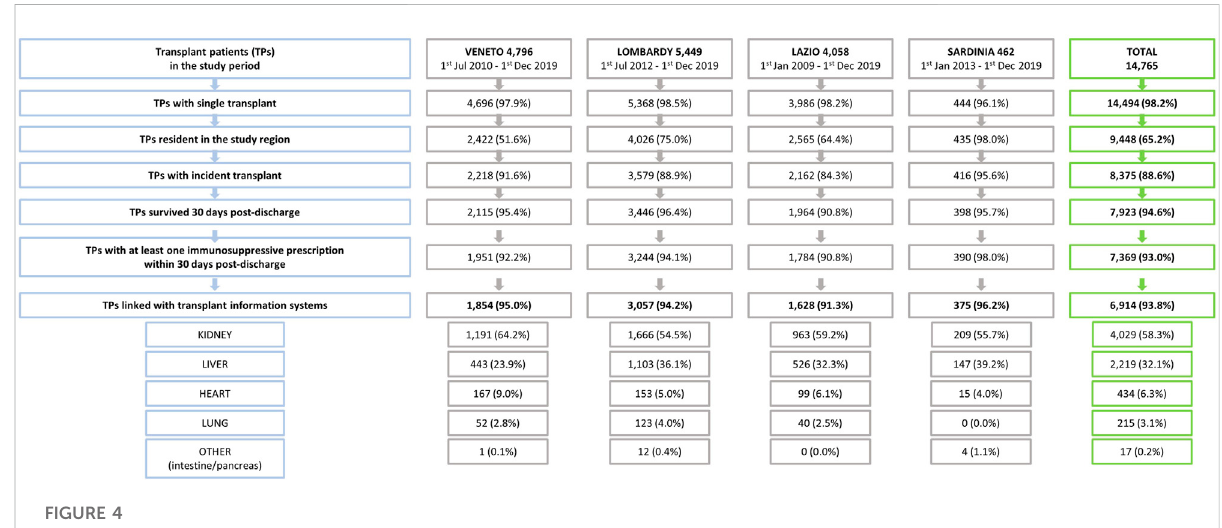
FIGURE 4 Study design including inclusion/exclusion criteria by region and